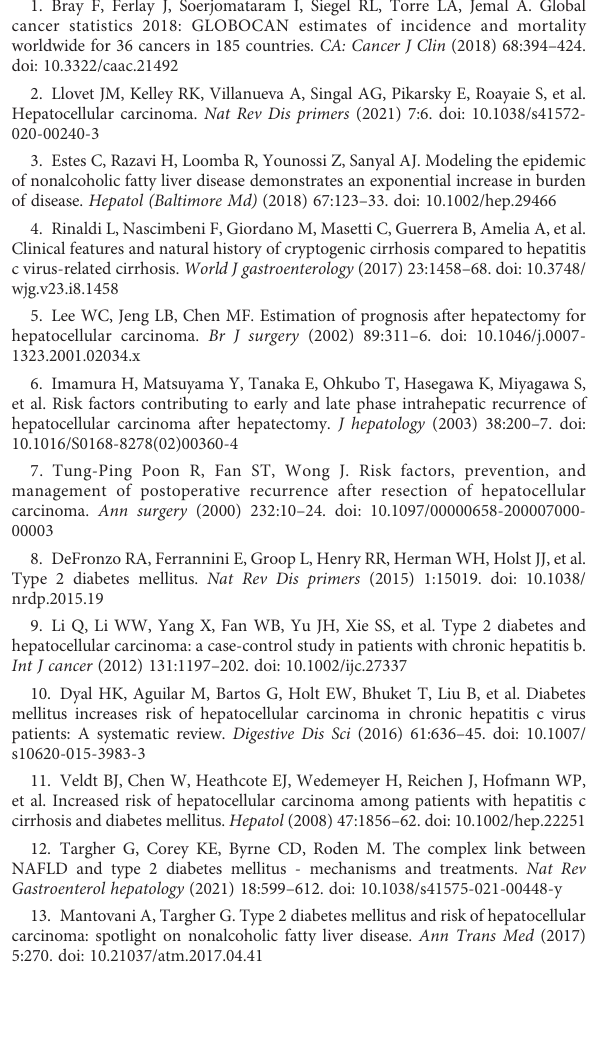
SUPPLEMENTARY FIGURE 1 Recurrence-free survival (RFS) (A) and overall survival (OS) (B) of HCC patients with microvascular invasion (MVI) associated with or without type 2 diabetes mellitus (T2DM) treated with laparoscopic liver resection